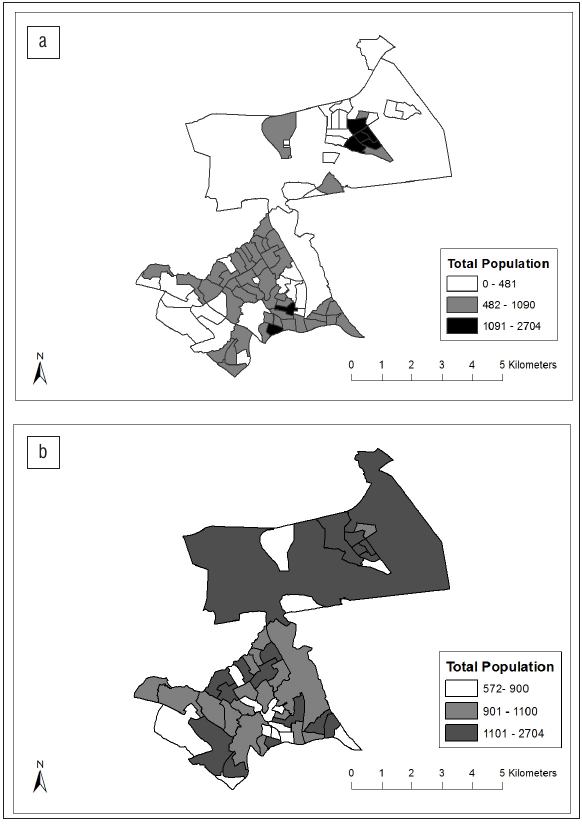
Figure 1: Phuthaditjhaba MainPlace: (a) original building block EAs, (b) newly created output